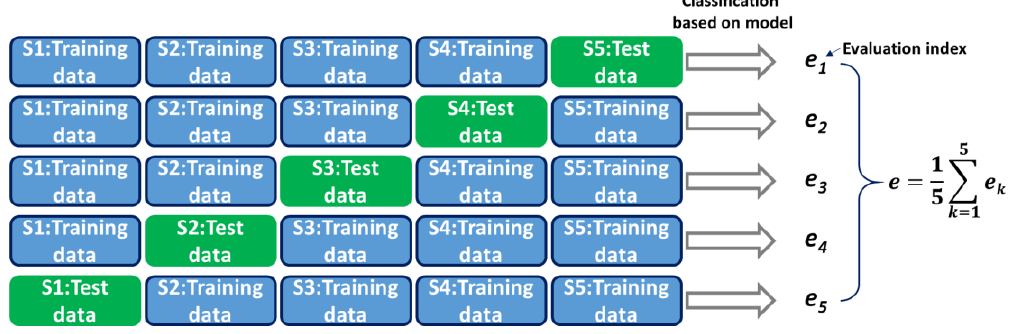
Figure 4. The k -Fold cross-Validation.